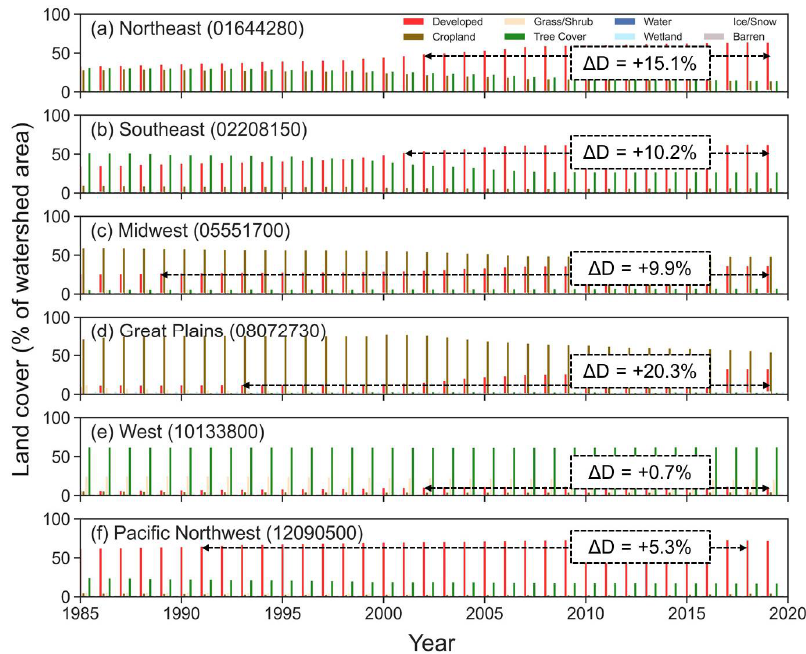
Figure 2. Land cover data of six watersheds from 1985 to 2019. The black dashed line shows the study years and corresponding stormflow data, and ΔD indicates the increase in urban area percentage at each watershed. Data sourced from the Land Change Monitoring, Assessment, and Projection (LCMAP) Collection 1.1 (https://www.usgs.gov/core-science-systems/eros/lcmap, accessed on 15 June 2022).